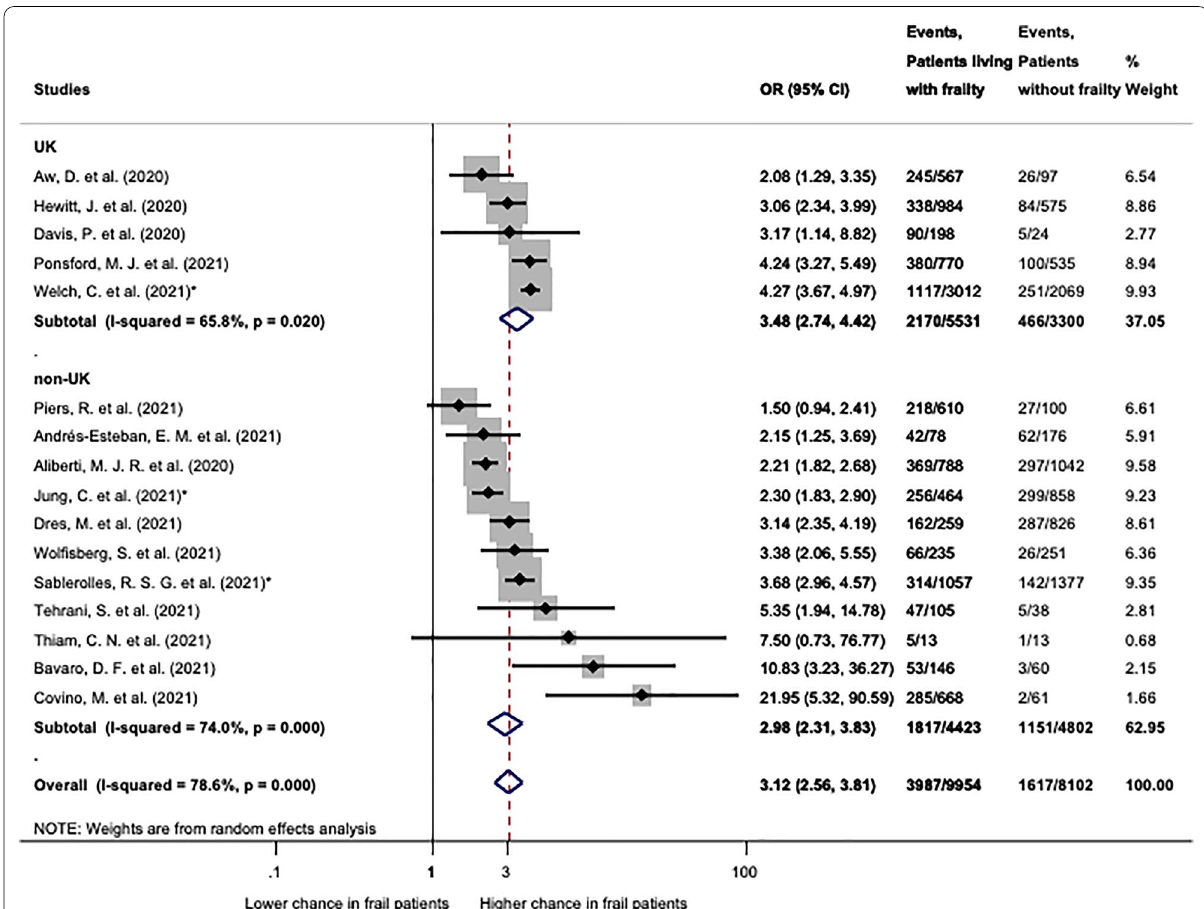
Fig. 2 Mortality in patients with frailty (CFS 4–9) compared to not frail (CFS 1–3). Patients living with frailty (CFS 4–9) had significantly higher chance of mortality in both groups (UK and non-UK) and overall. Note that heterogeneity was significant in all cases. OR: odds ratio; CI: confidence interval. p < 0.1 was considered significant. *Indicates multicentric studies including patients from both groups, but the majority of patients affiliate to the correspondent